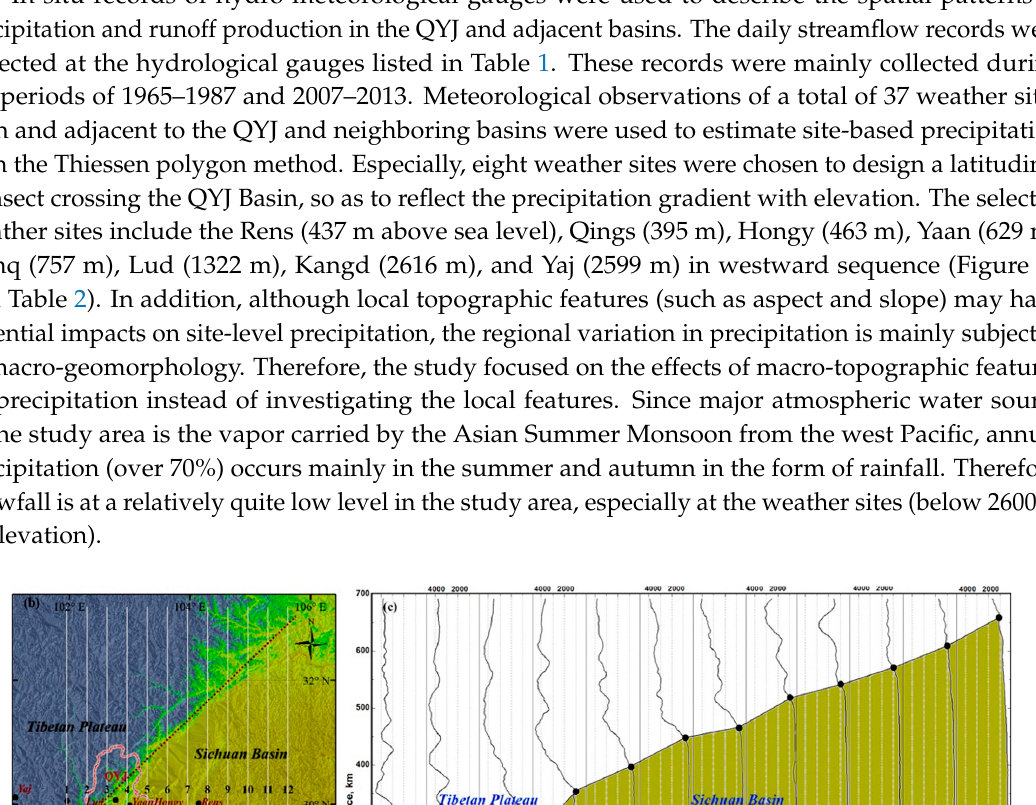
Table 1. The hydrological gauges in the QYJ and adjacent basins. For simplicity, the gauge names are used to denote related basins.